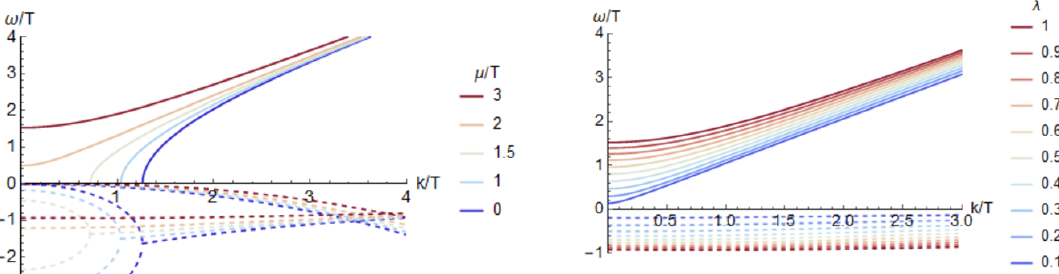
Figure 2 . The transverse collective modes in absence of the scalar sector. Solid lines are the real parts of the modes, 4 and dashed lines the imaginary parts. Left: the modes at di(cid:11)erent values of the dimensionless chemical potential (cid:22)=T . Note especially that the imaginary part (here mostly horizontal) of the mode with non-zero real part breaks apart into two purely imaginary modes at small k and (cid:22) . Right: the mode in the Maxwell sector at (cid:22)=T = 3 as a function of the EM coupling (cid:21)